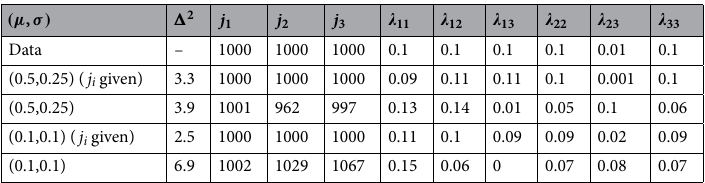
Table 5. Estimated parameter values after minimization for artificial data.